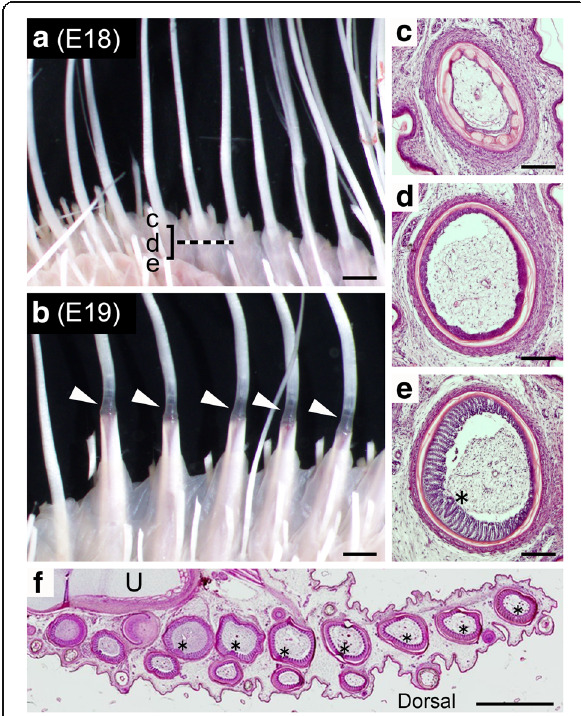
Fig. 2 Development of remex-type flight feathers before hatching.